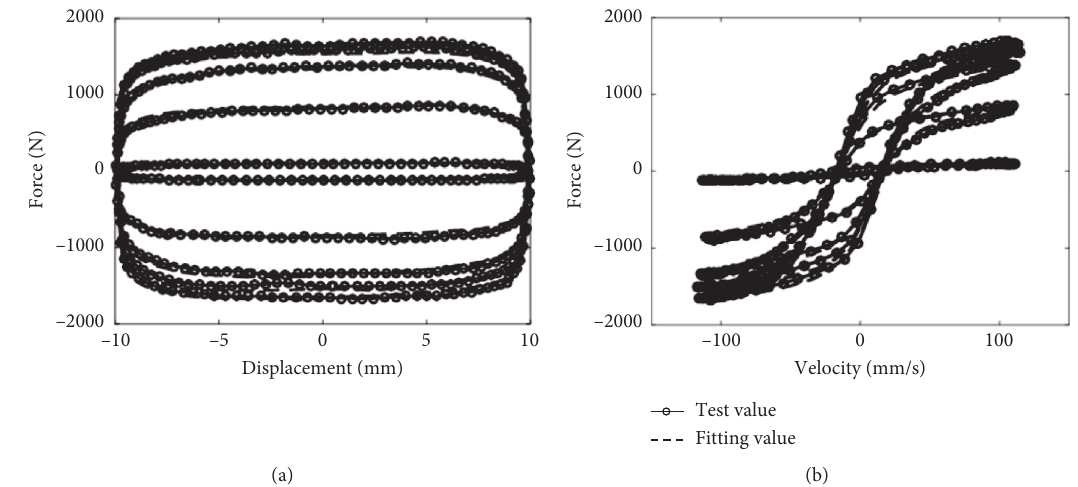
Figure 2: Comparison between predictions and experimental results.